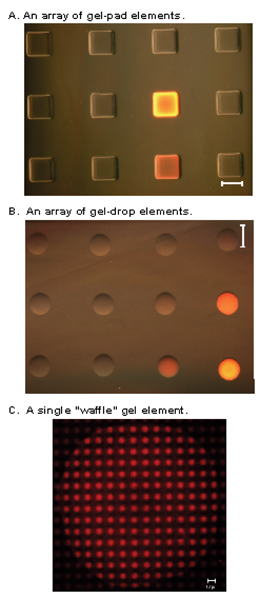
Fluorescent image of gel-pad, gel-drop, and waffle arrays. Panel A and B: fluorescent and white-light image of Alexa 594-labeled oligonucleotides hybridized to probes on a subsection of the A) gel-pad array or B) gel-drop array. Panel C: stacked confocal image of Cy3-labeled control probe on a single waffle gel element. Scale bar in Panel A and B is 100 μm and Panel C is 10 μm.